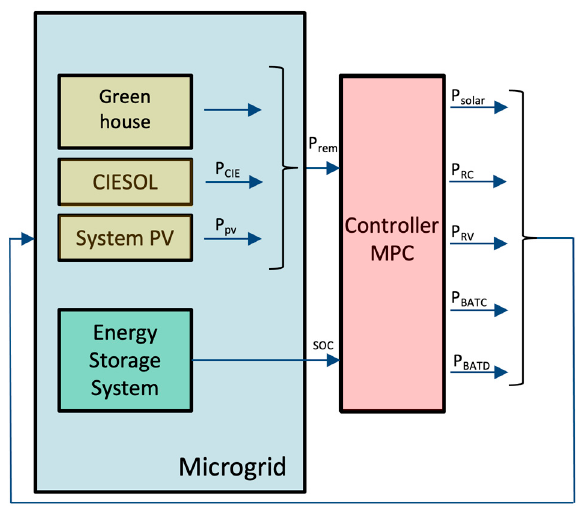
Figure 5. MPC controller in a micro-network